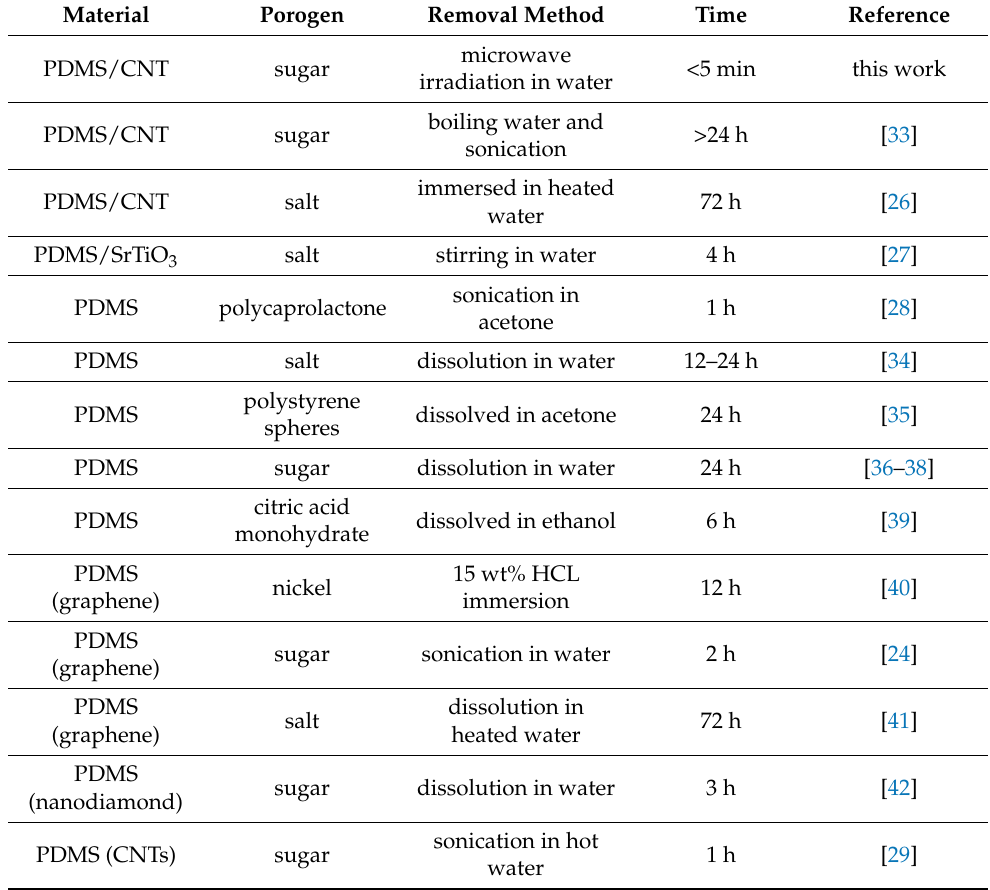
Table 1. Comparison of time required to remove the sugar porogen via microwave-assisted dissolu- tion with different porogen removal methods used to fabricate PDMS